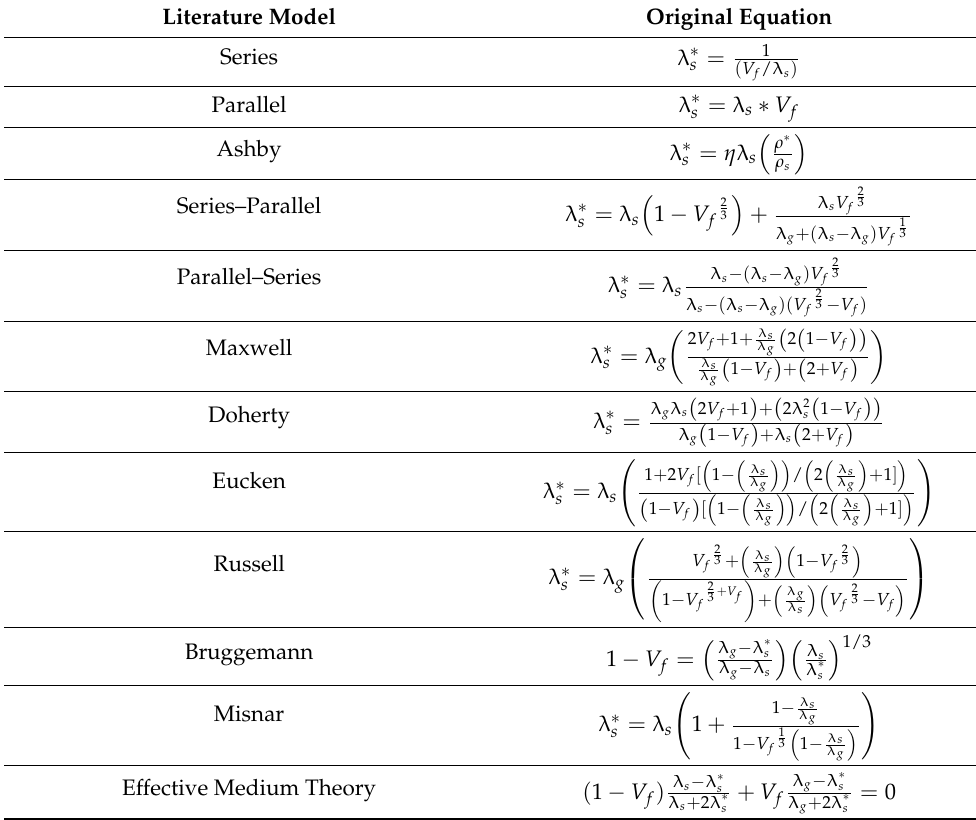
Table 3. Theoretical models under consideration